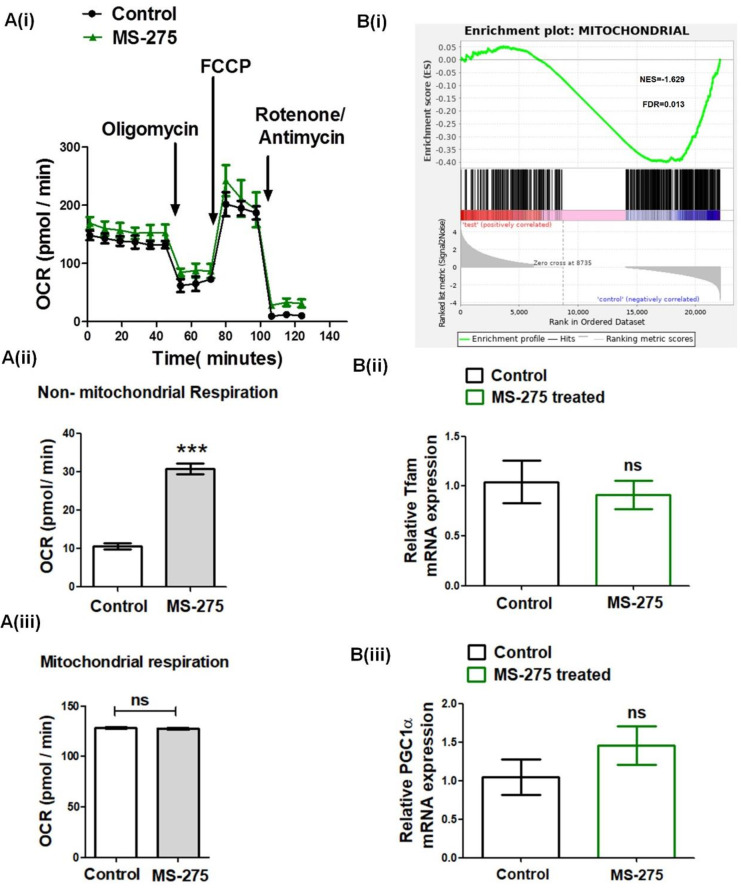
A (i) Real-time respirometry depicting oxygen consumption rate in the control and MS-275-treated pancreatic beta cells measured in Seahorse XF24 extracellular flux analyzer.The cellular respiration was dissected into non-mitochondrial (A (ii)) and mitochondrial respiration (A (iii)). Data are mean (± S.E) of three stimulated wells measured in triplicate. ***p<0.001, **p<0.01 for Student’s t-test (unpaired) comparing respiratory parameters in control and MS-275-treated cells; n.s = nonsignificant. B(i). GSEA of the mitochondrial genes in control and MS-275-treated pancreatic beta cells. The graph represents the profile of the running enrichment score and positions of the Gene Set members in the rank order list. NES = Normalized enrichment score, FDR = False Discovery Rate B (ii) The Effect of MS-275 on the mRNA expression of Tfam; the quantification being carried out using the 2-ΔΔCT method and the data normalized using 18S rRNA as reference. Results are represented as the mean (± SE) of three independent experiments. ns = non-significant B(iii). The Effect of MS-275 on the mRNA expression of PGC-1α; the quantification was carried out using the 2-ΔΔCT method and the data normalized using 18S rRNA as reference. Results are represented as the mean (± SE) of three independent experiments. ns: non-significant.